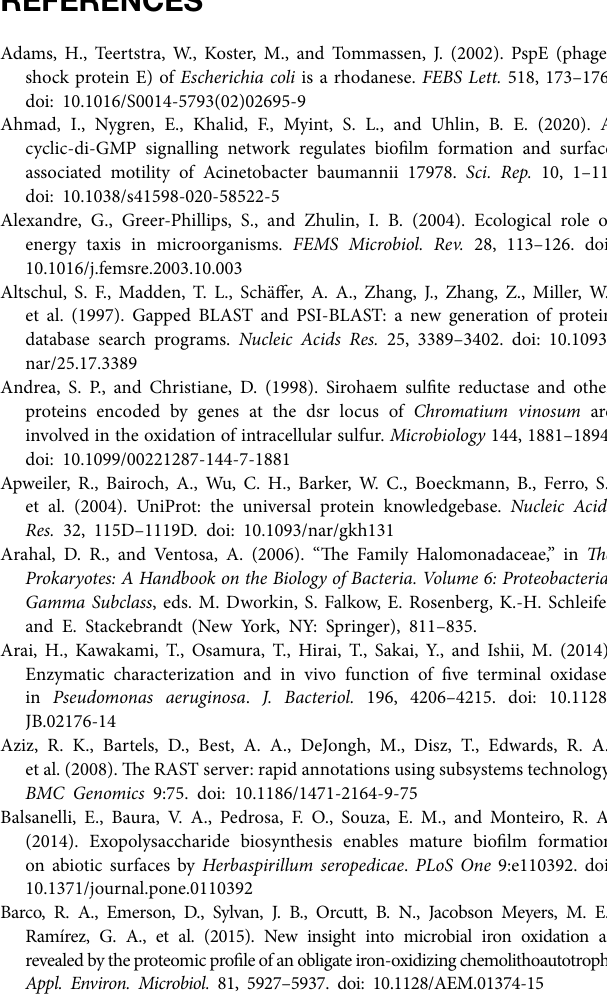
Supplementary Figure S3 | Neighbor-joining phylogenetic tree of TsdA4151, TsdB4152, and homologous proteins. Percentage bootstrap values above 50% (1,000 replicates) are shown at branch nodes. Supplementary Figure S4 | The growth course of Halomonas titanicae SOB56 under different concentrations of metal ions. Supplementary Figure S5 | Sodium ion tolerance of Halomonas titanicae